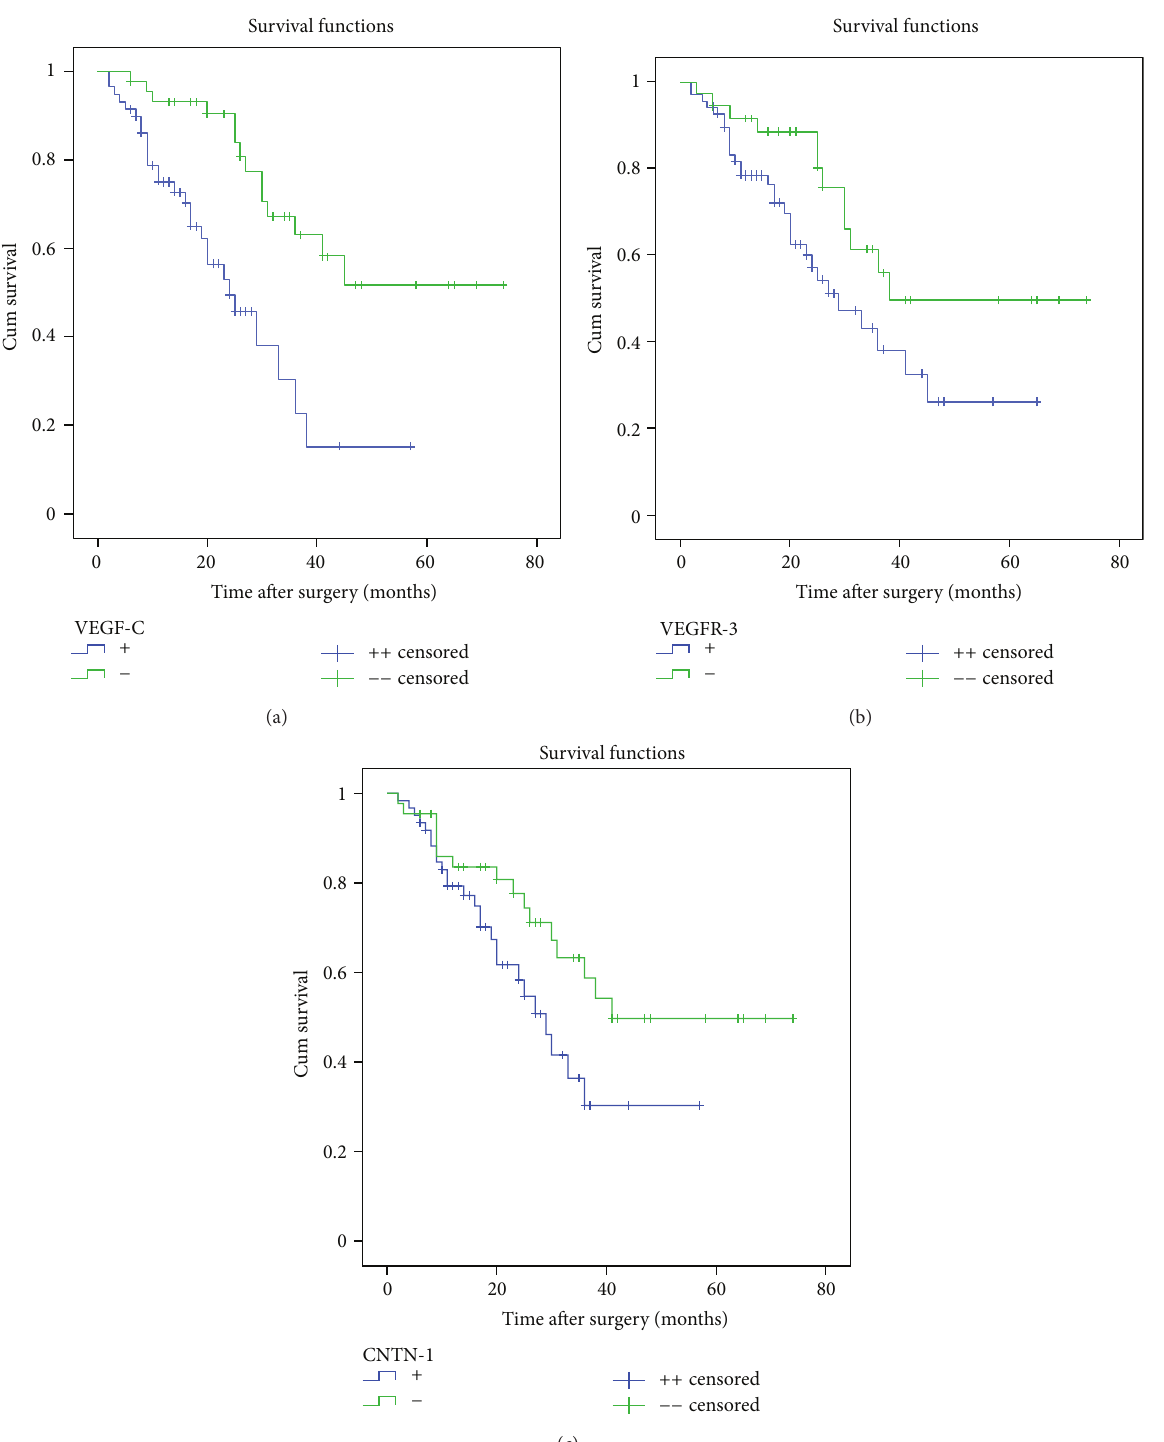
Figure 3: Kaplan-Meier survival curves of patients with gastric cancer according to VEGF-C, VEGFR-3, and CNTN-1 protein expression. Correlation between overall survival of the patients and VEGF-C expression was found to be statistically significant (log rank: 𝑃 < 0.001 ) as well as that between survival and VEGFR-3 expression (log rank: 𝑃 = 0.034 ), survival and CNTN-1 expression (log rank: 𝑃 = 0.012